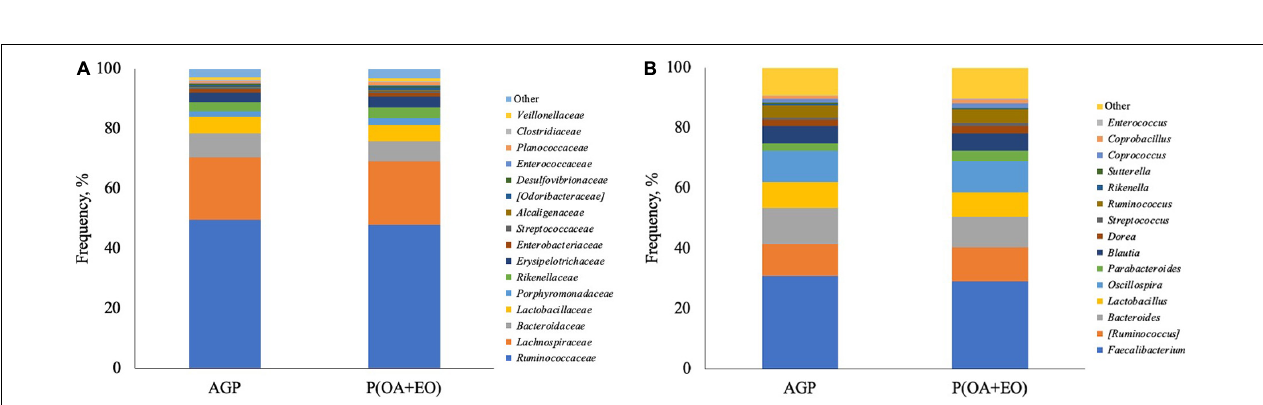
Frontiers in Physiology |